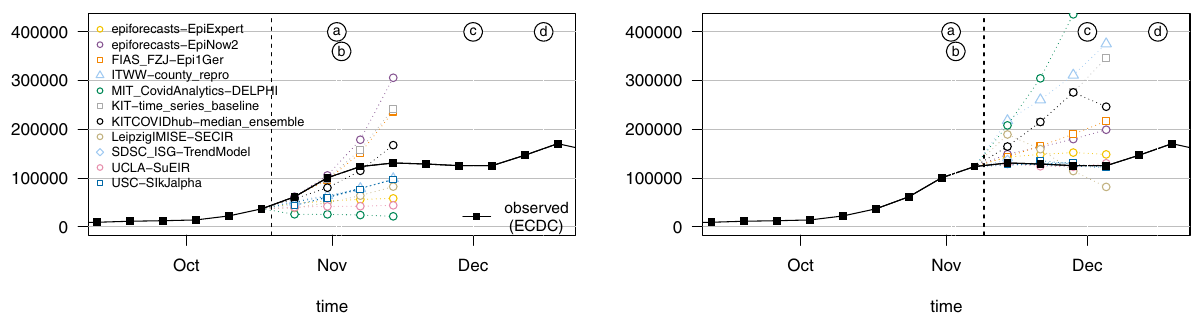
Fig. 4 Illustration of heterogeneity between incident case forecasts in Germany. a Point forecasts issued by different models and the median ensemble on 19 October 2020. b Point forecasts issued on 9 November 2020. The dashed vertical line indicates the date at which forecasts were issued. Events marked by letters a – d are explained in